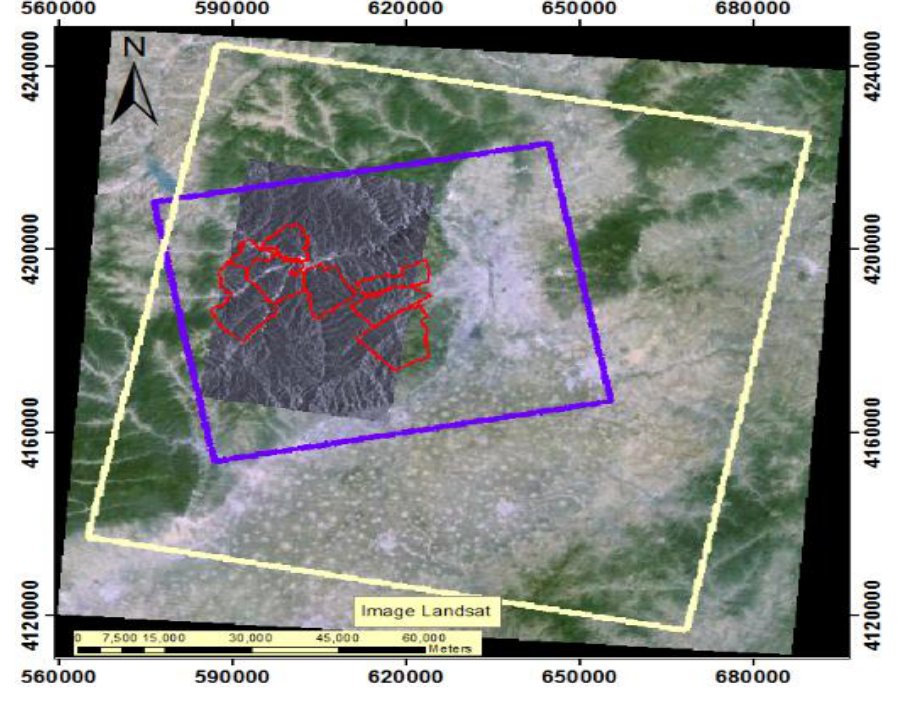
Figure 1. Five active coal mines are shown below in red polygon on Google Earth (UTM). Blue and yellow frame indicate coverage of ENVISAT and ALOS images, respectively. The SAR amplitude image indicates the coverage of TerraSAR-X